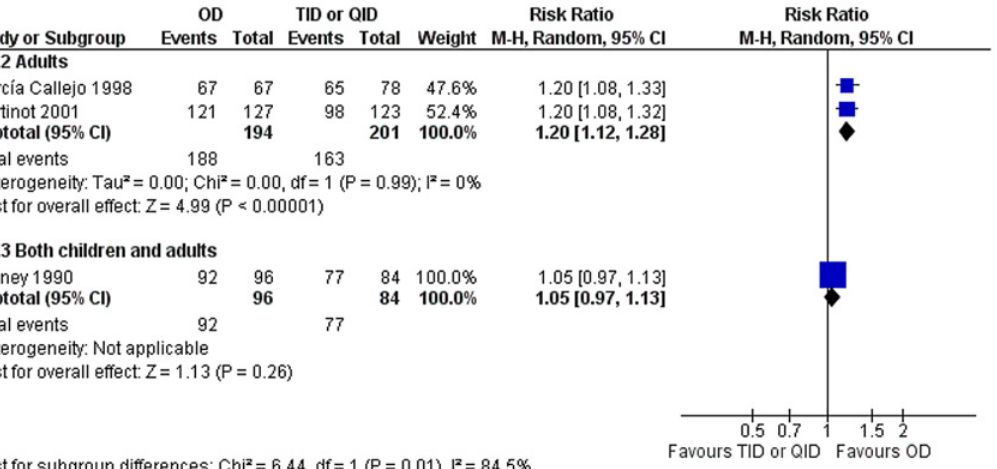
Figure 7. Forest plot depicting the risk ratios (RR) of compliance of patients receiving an antibiotic once-daily versus an antibiotic of different class thrice or four times